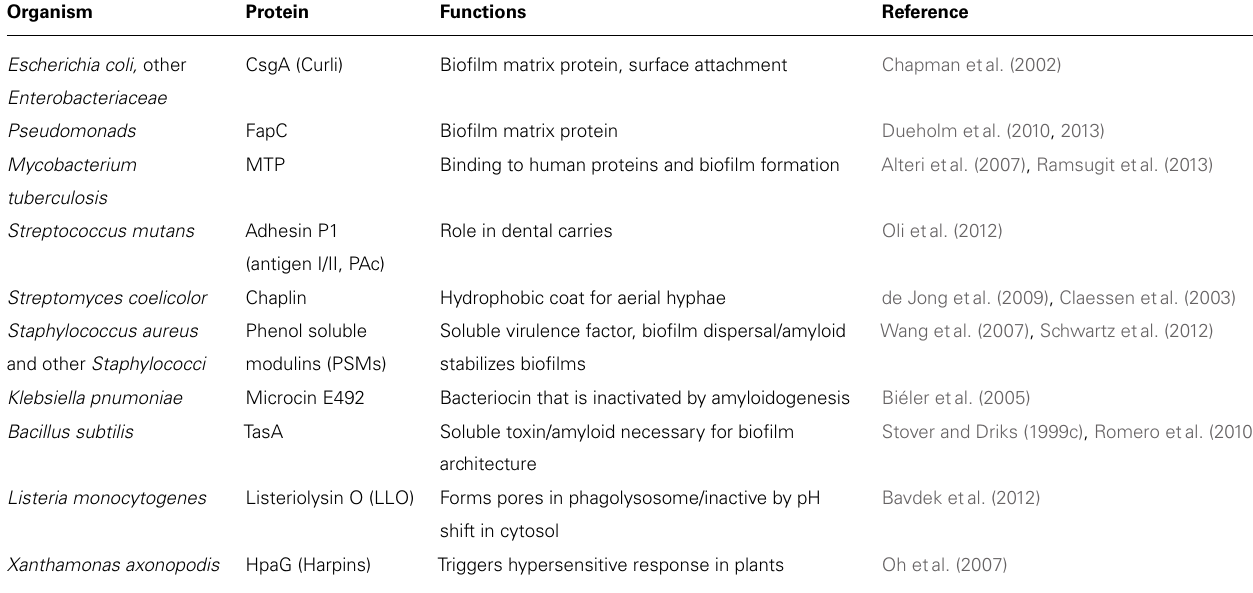
Table 1 | Bacterial functional